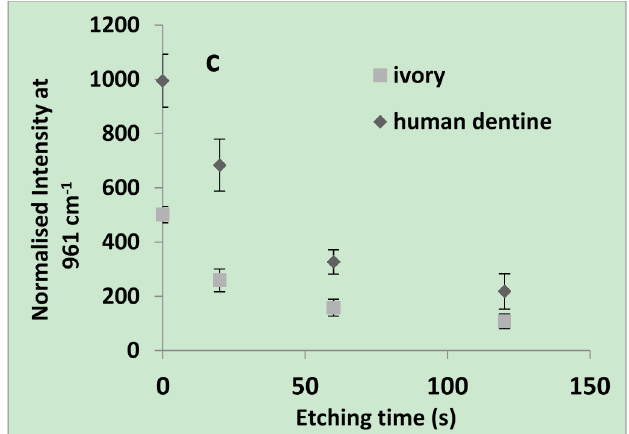
Figure 1. Chemical analysis of dentine using Raman spectroscopy. Raman spectra of ( a ) ivory; and ( b ) human dentine both after 0, 20, 60, or 120 s of acid etching; ( c ) Normalized intensity at 961 cm − 1 is plotted against etching time in seconds ( n = 5).